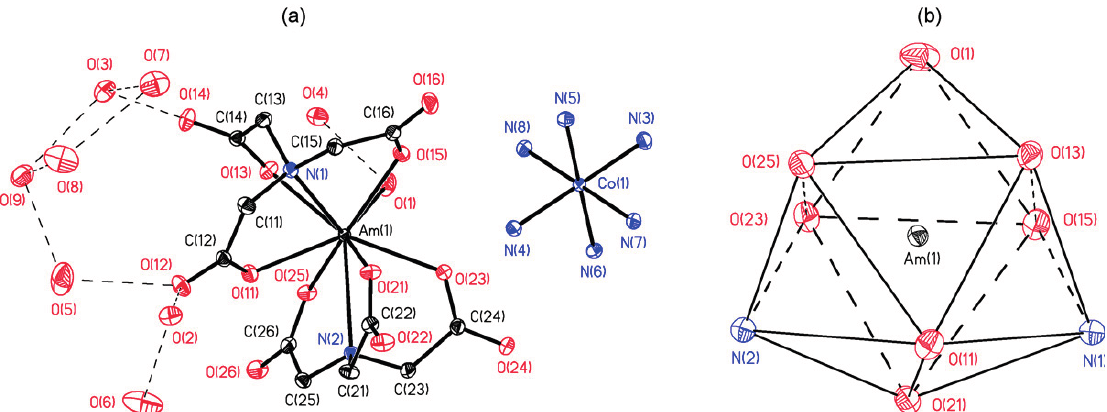
) ] K[Am (Cit) (H O) ]·18H O. Thermal 3 6 2 3 4 2 3 2